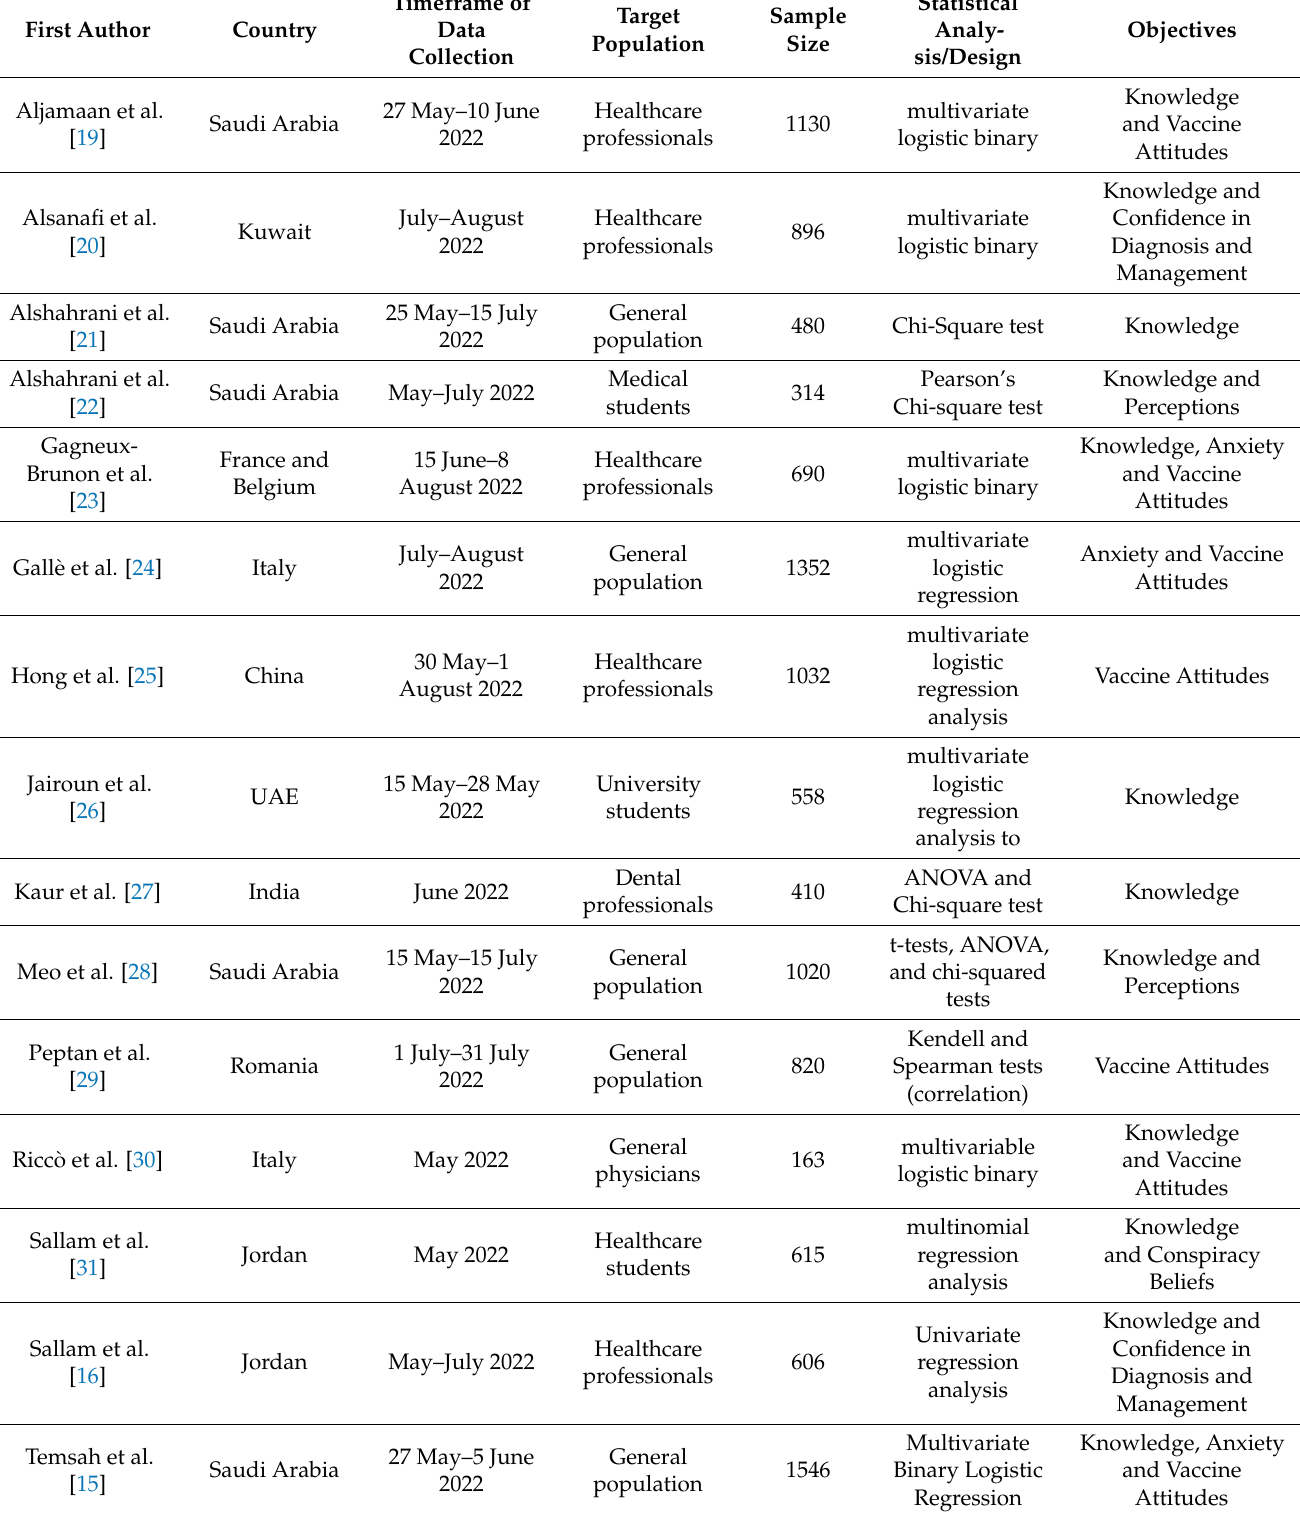
Table 1. General Characteristics of the Included